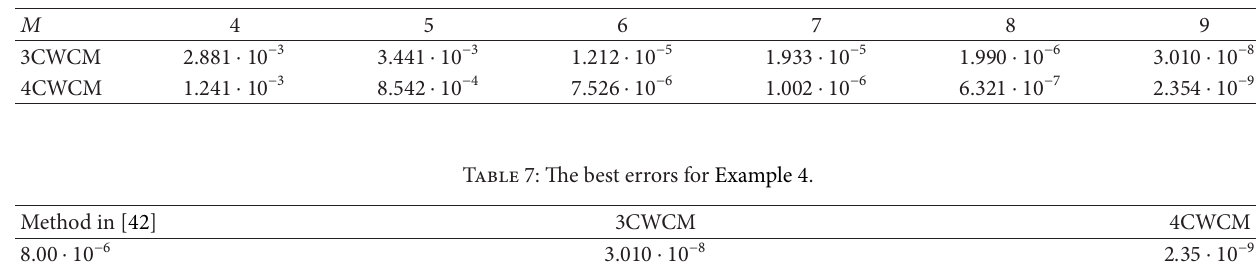
Table 6: The maximum absolute error 𝐸 for Example 4.